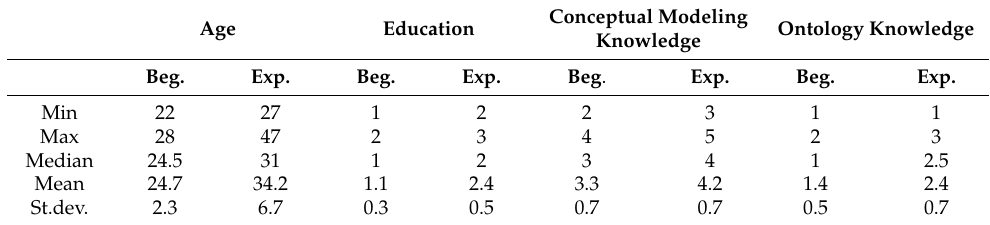
Table 4. Statistics of the participants (“Beg.” indicates statistics for beginners, “Exp.” indicates statistics for experts): for Education, 1 = Bachelor’s degree, 2 = Master’s degree, 3 = Ph.D; conceptual modeling and ontology knowledge are on a scale from 1 to 5, with 1 indicating no knowledge. Age